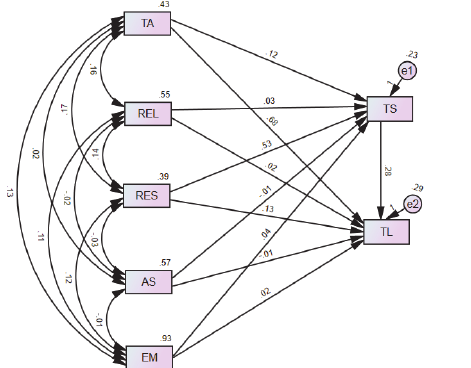
Fig. 2 . The results of confirmatory factor analysis Fig. 3. The results of structural path